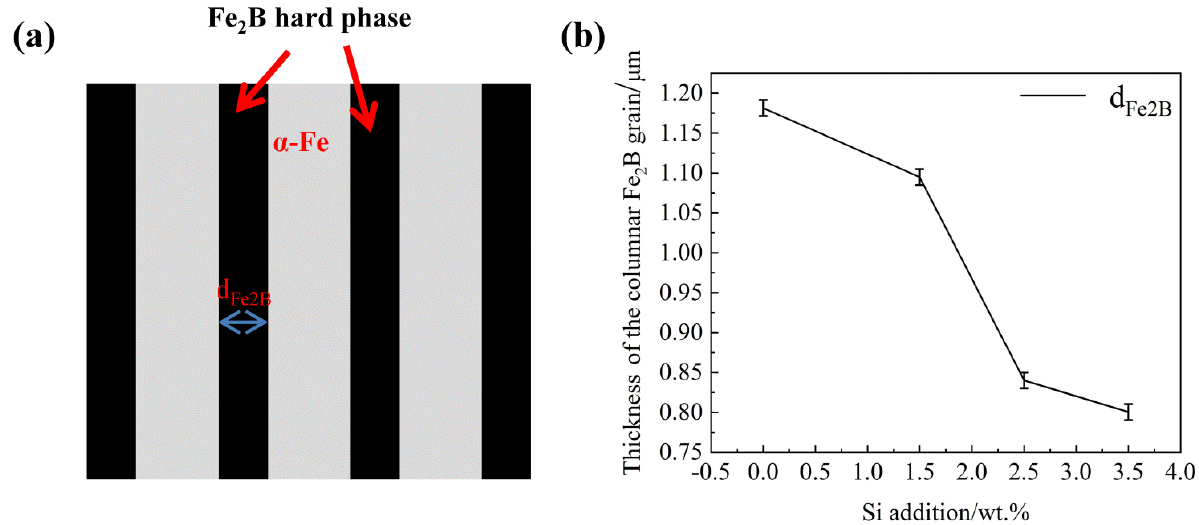
Figure 3. Relationship between average thickness of the columnar Fe 2 B grain (d Fe2B ) with Si con- tents: ( a ) the schematic diagram of d Fe2B , ( b ) d Fe2B vs. Si content. ( a ) the schematic diagram of d Fe2B , ( b ) d Fe2B vs. Si